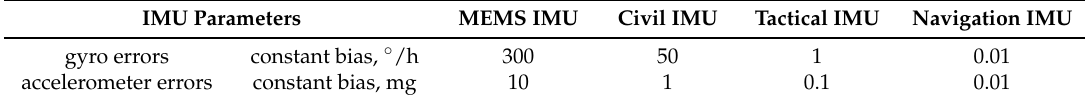
Table 4. Input IMU parameters [27] for local frequency prediction in SDR.